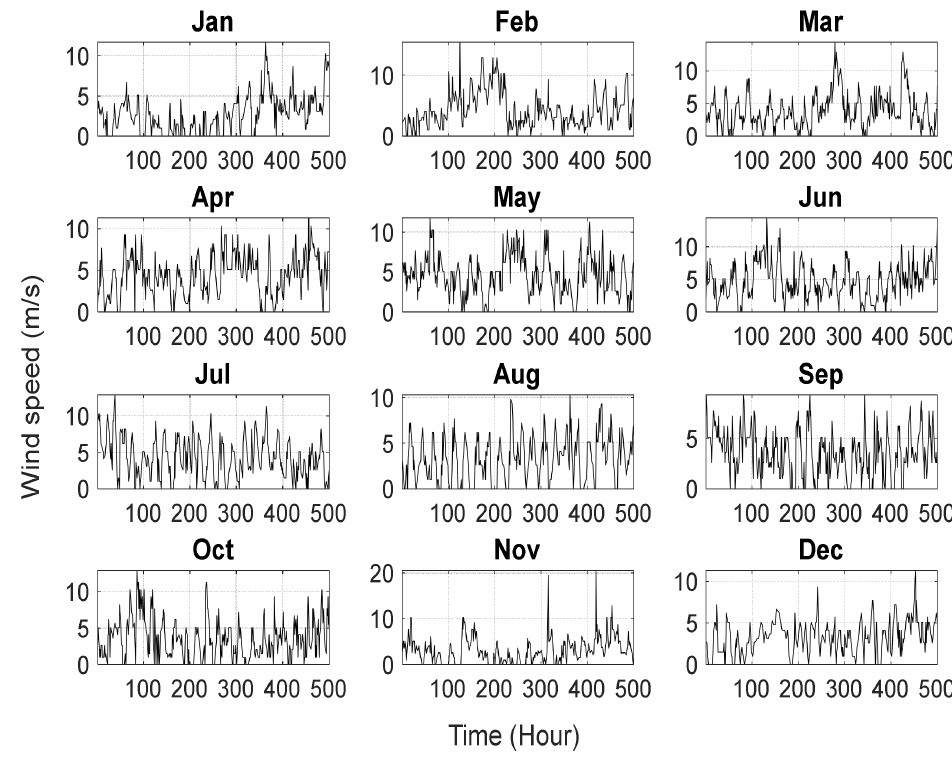
Figure 5. Monthly wind speed data of the case